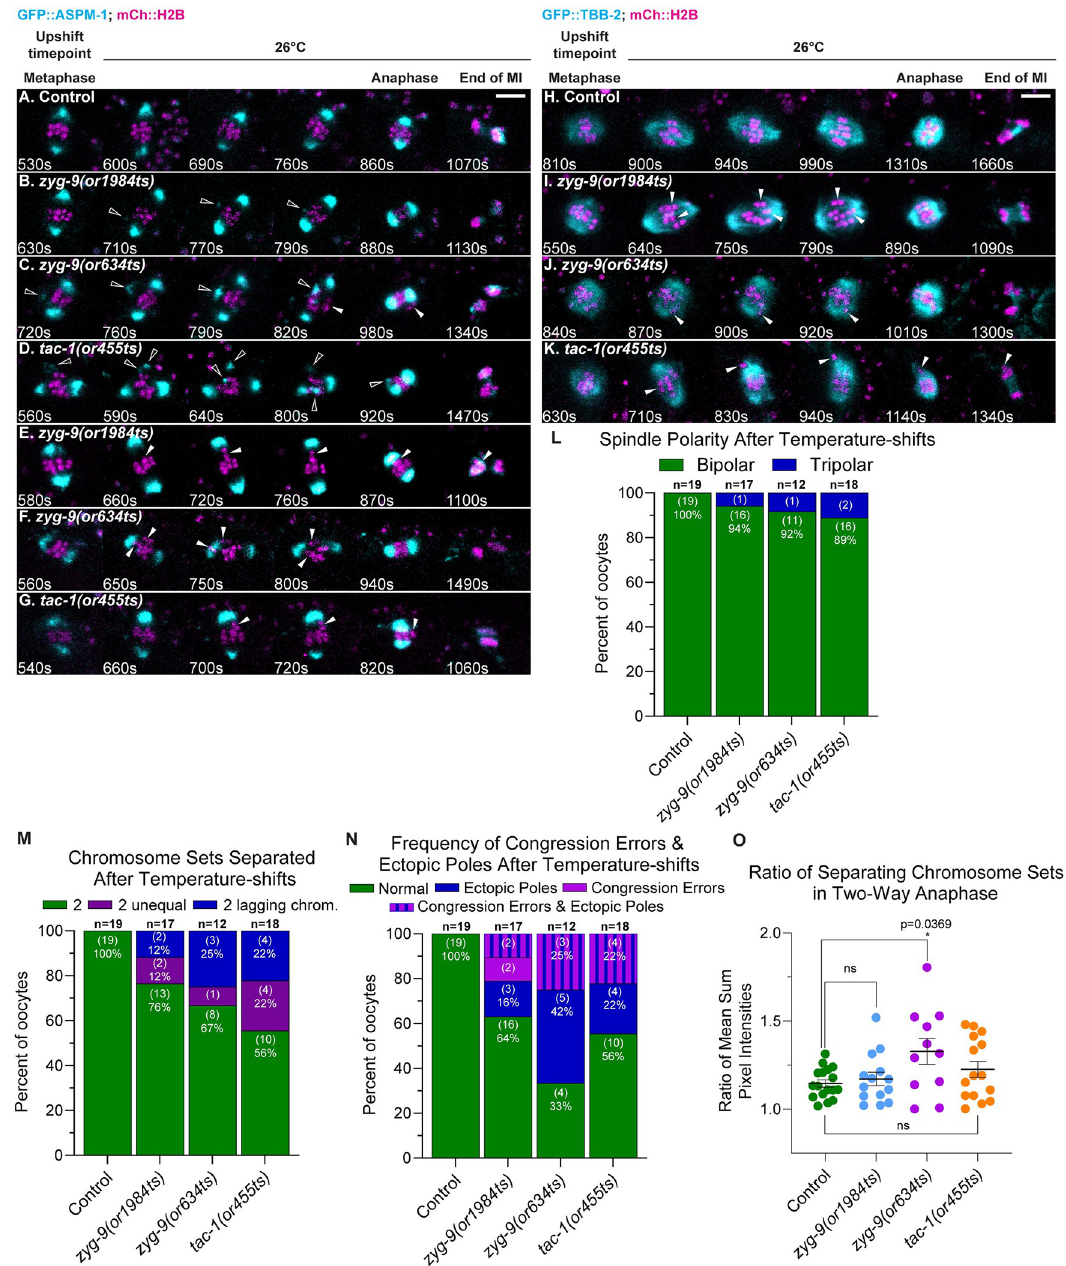
Fig 5. ZYG-9 and TAC-1 suppress ectopic spindle pole formation and maintain chromosome congression during meiosis I metaphase. (A-K) Time-lapse maximum intensity projection images of live control and TS mutant oocytes upshifted at metaphase and expressing either GFP::ASPM-1 and mCherry::H2B (A-G) or GFP::TBB-2 and mCherry::H2B (H-K). Montage frames highlight defects following metaphase upshift through to the end of meiosis I. Hollow arrowheads indicate ectopic spindle poles and solid arrowheads indicate chromosome congression errors. (L-N) Number of spindle poles present at the onset of spindle shortening in metaphase upshifted oocytes (L); of chromosome congression errors (M); of ectopic poles in metaphase upshifted oocytes (M); of chromosome sets separated during anaphase (N) for metaphase upshifted oocytes; number of oocytes examined indicated above each bar, number scored with each phenotype shown in parentheses inside bars with corresponding percent below. (O) Ratio of fluorescence intensity of two separated chromosome sets in metaphase upshifted oocytes (see 5N) at the end of anaphase B. � , P < 0.05 (S2 Data). Scale bars = 5 μ m.